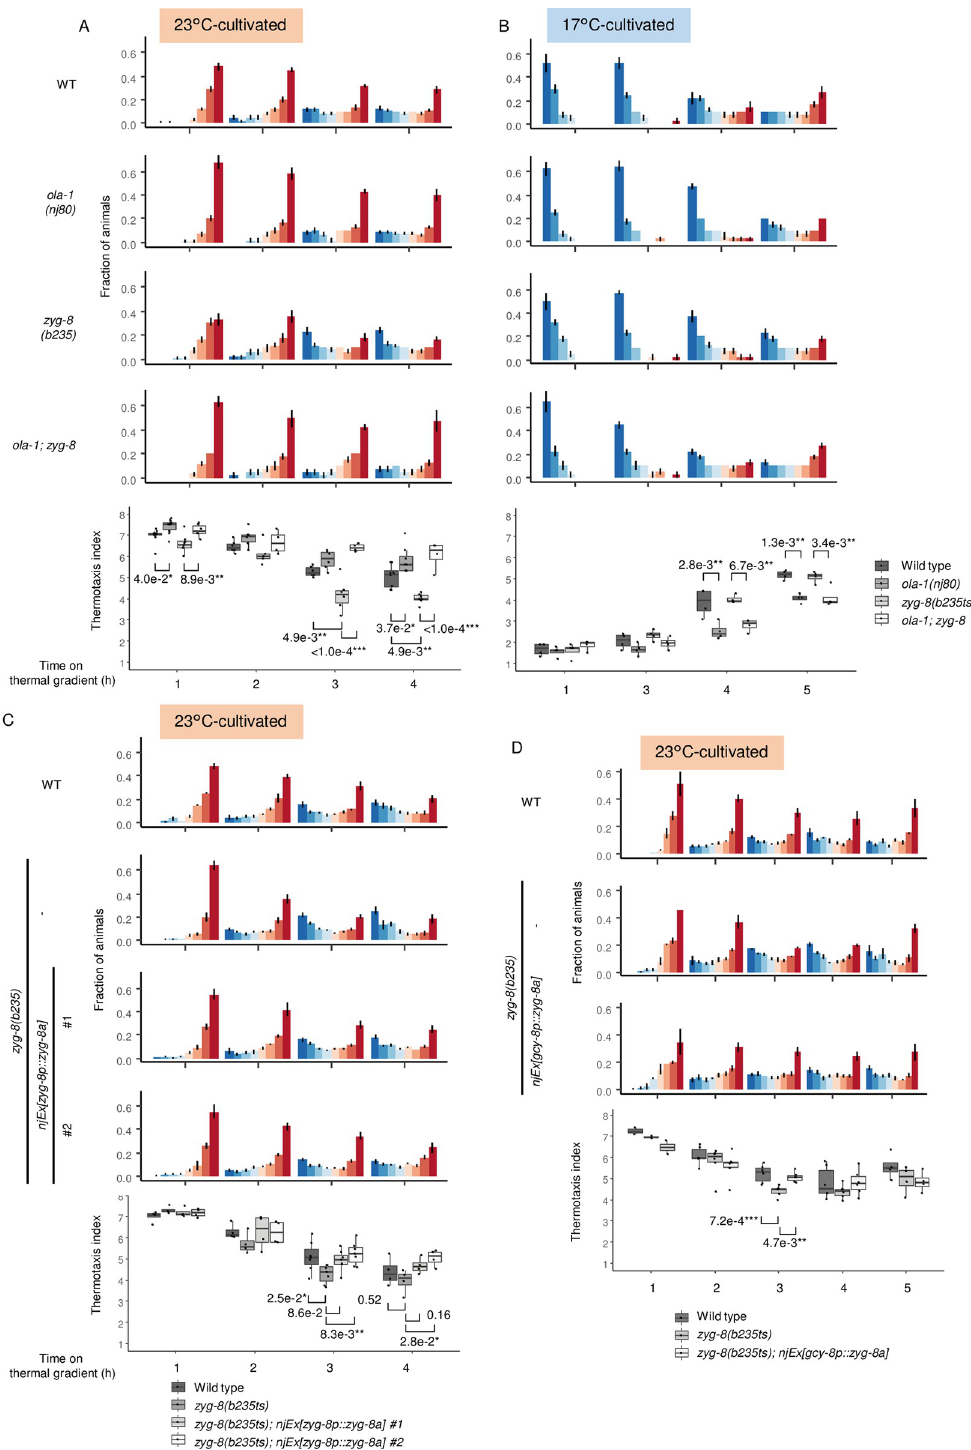
Fig 7. zyg-8 mutants are faster in the transition of the thermotactic behavior. (A-B) Wild type, ola-1(nj80) , zyg-8 (b235ts) and ola-1; zyg-8 animals were cultivated at 23˚C for 3 days (A) or at 17˚C for 5 days (B) and allowed to freely migrate on a thermal gradient for the time indicated. p values were indicated (Tukey-Kramer test). n = 4–10 (A) and n = 4 (B). (C-D) Wild type and zyg-8(b235ts) animals and zyg-8(b235ts) animals that express ZYG-8 isoform a under zyg-8 promoter (C) or gcy-8 promoter (D) were cultivated at 20˚C for 2.5 days and the at 23˚C for 1 day to avoid severe